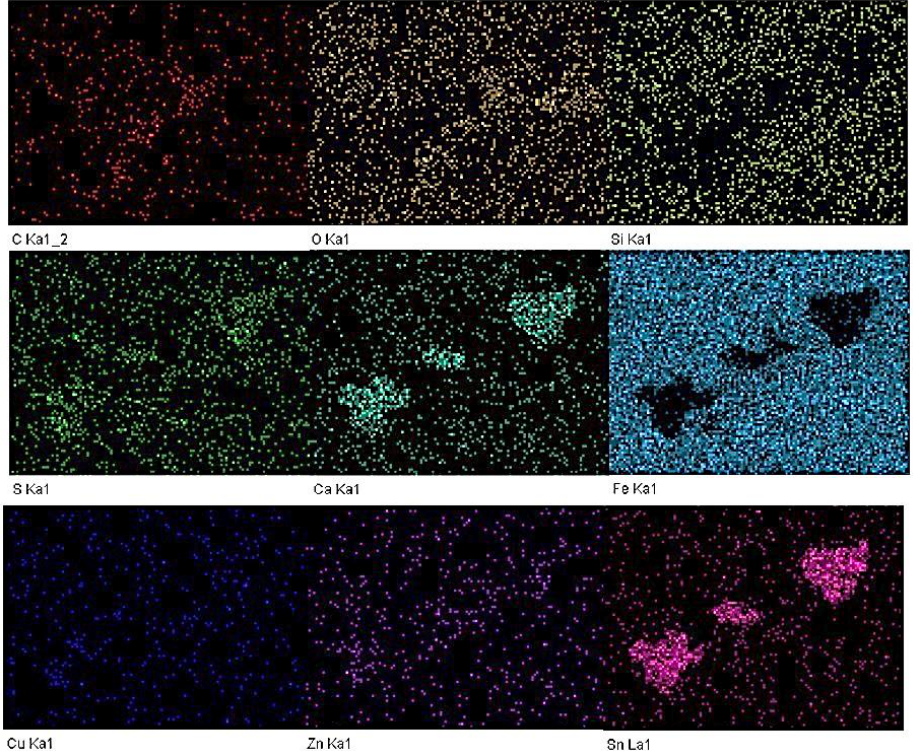
Figure 9. Surface topography ( a ), enlarged area topography ( b ) and position d ( c ) and position e ( d ) element contents of the cylinder liner matched with CuSn-Cr coated piston ring.